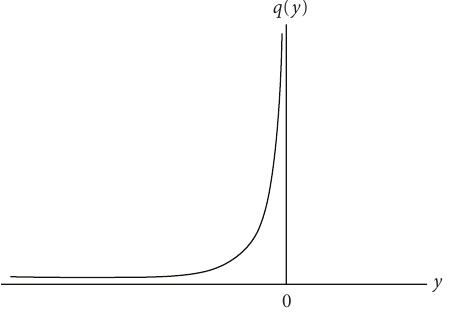
Figure 3: Typical penalty